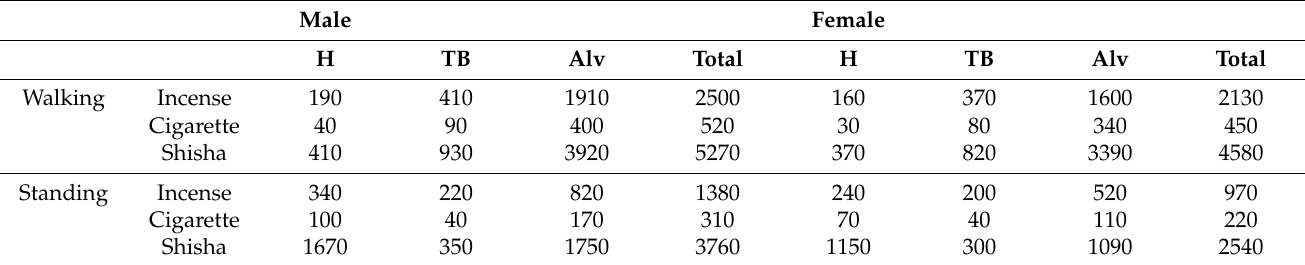
Table 3. Regional inhaled deposited dose rate ( µ g/h) calculated based on submicron particle mass concentration ( PM 2.5 ) for adult males and females during two main activities (walking 4 km/h and standing). Abbreviations H, TB, and Alv are for head and throat airways, tracheobronchial, and pulmonary/alveolar regions,